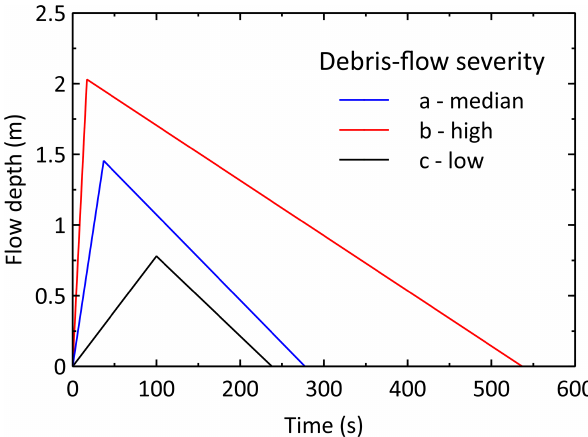
Figure 7. Simplified triangular debris-flow hydrographs derived from debris-flow surges recorded from 1990 to 2019.